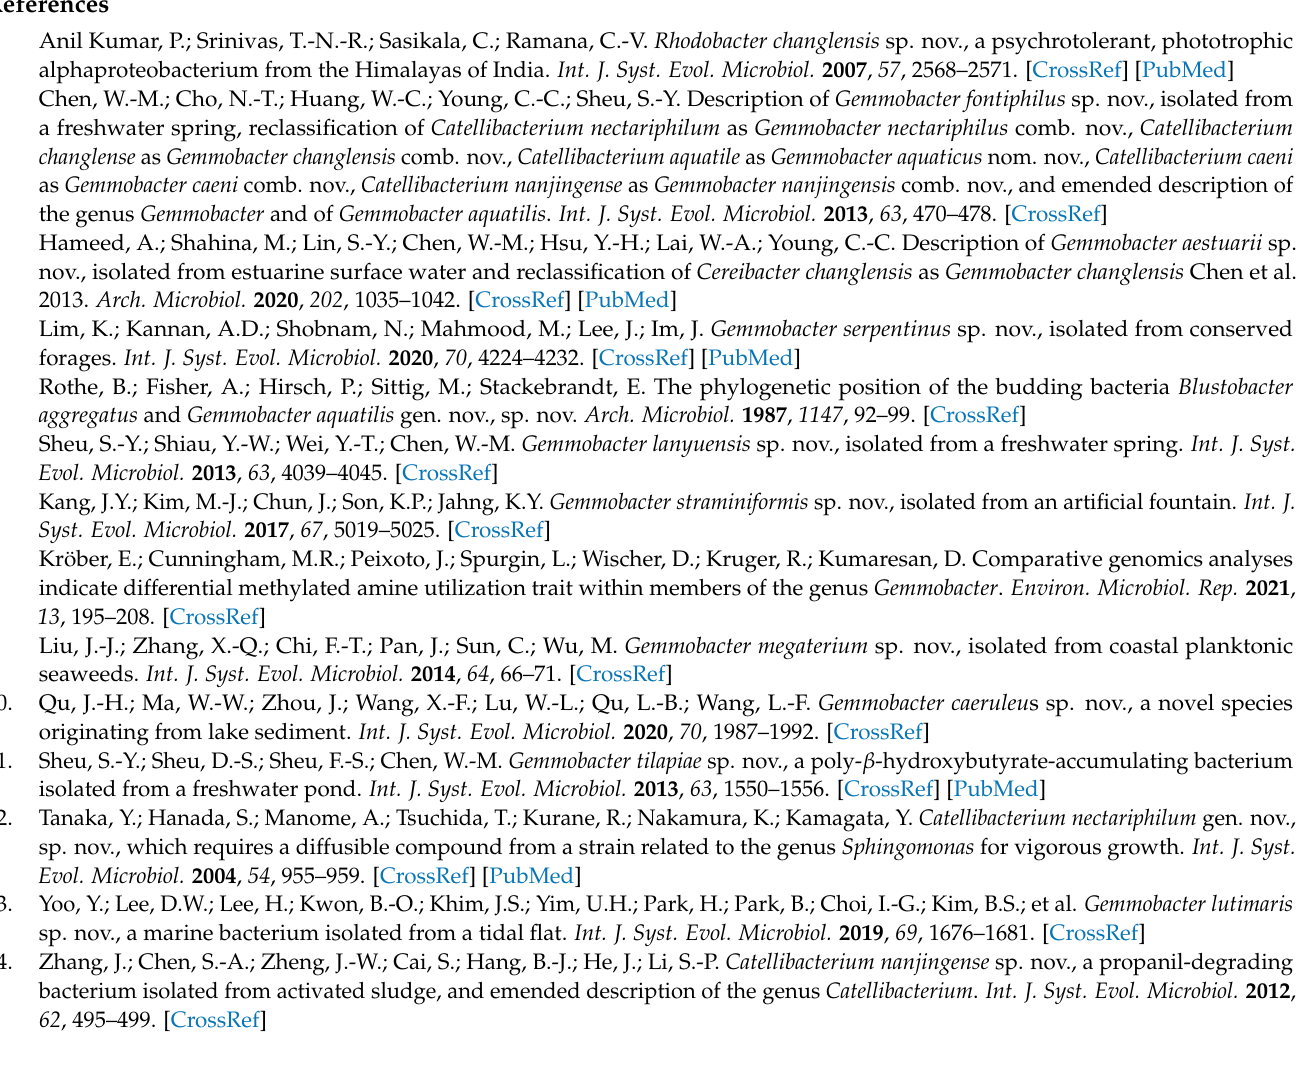
whole genomes using the unweighted pair group method with the arithmetic averages clustering algorithm (UPGMA). Figure S5. Graphic representation of circular genome plot of strain con5 T . The circles from inside to outside represent GC skew ([G − C]/[G + C]) plot of the genome, GC content, CDS-reverse, CDS-forward, contigs, and position label. Table S1. General genome features of strains con5 T and con4. Table S2. Genomic feature of type strain con5 T